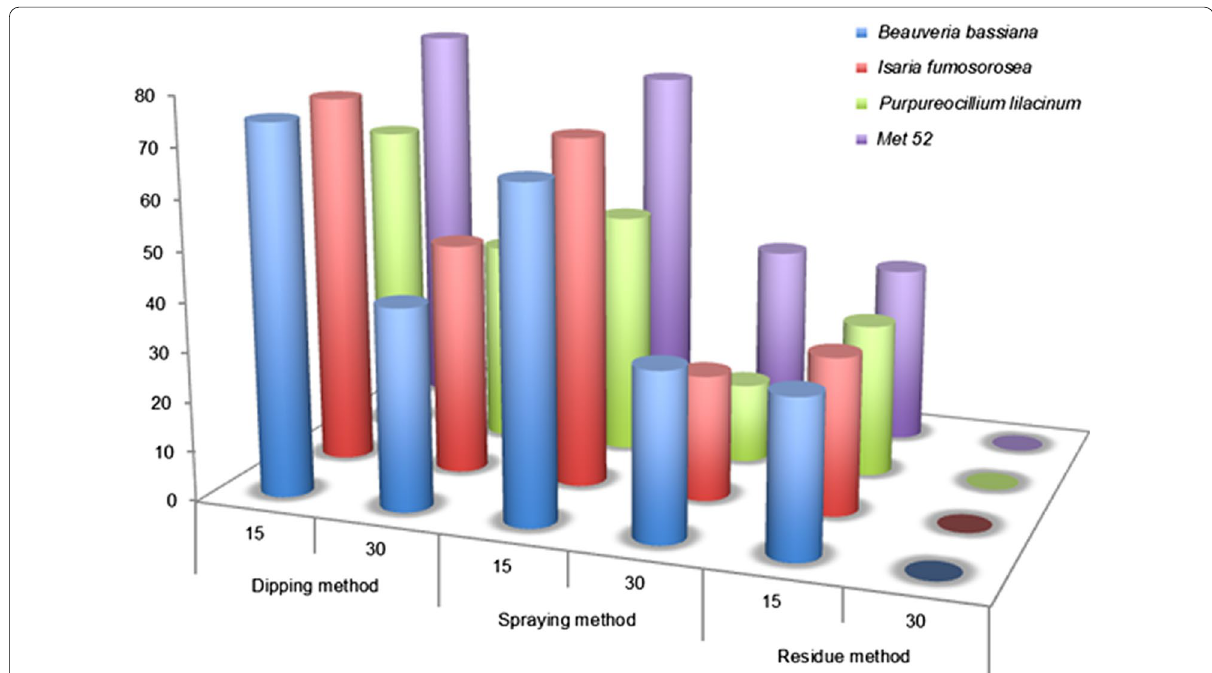
Fig. 1 Efficacy rates of the entomopathogenic fungi on the gallery formation on tomato leaves 15 and 30 days after the applications by three methods